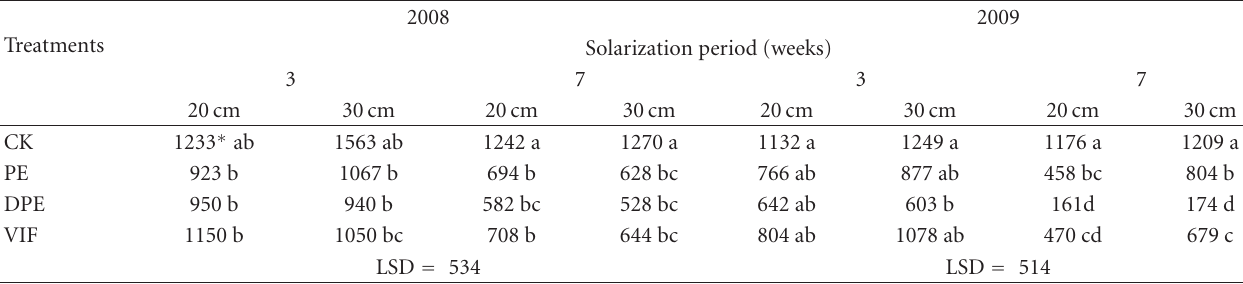
Table 2: E ff ect of solarization with regular polyethylene (PE), double regular polyethylene (DPE), and virtually impermeable films (VIF) on population of Fusarium oxysporum f. sp. lycopersici in soil.